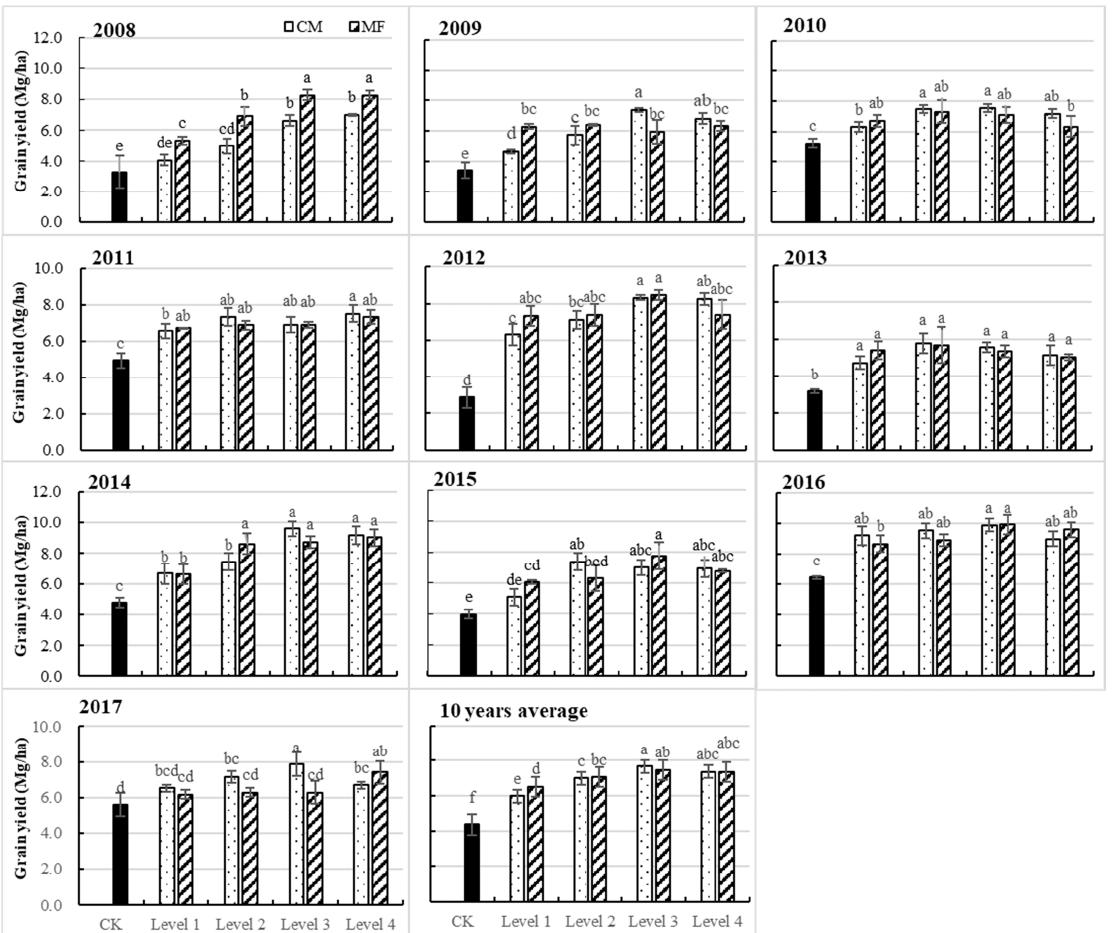
Figure 2. Maize yields observed under two types of fertilizer and four application levels along a 10-year field experiment (2008–2017) at North China Plain region, China. CK: Control treatment (non-fertilized); CM: cattle manure; MF: mineral fertilizer; Level 1 corresponding to 3 t CM ha − 1 , Level 2 to 6 t CM ha − 1 , Level 3 to 9 t CM ha − 1 , Level 4 to 12 t CM ha − 1 . Error bars are standard error of three replicates. Di ff erent lowercase letters indicate statistical di ff erences ( p ≤ 0.05) among fertilizer